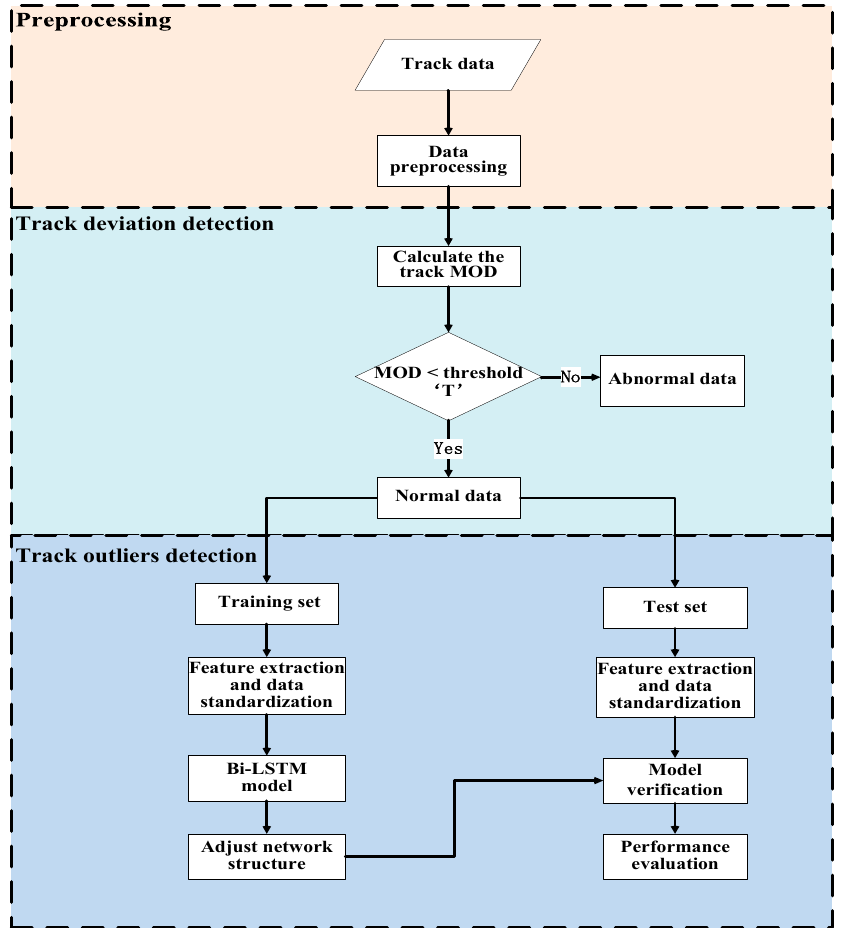
Figure 1. Flowchart of MOD-Bi-LSTM anomaly detection algorithm.